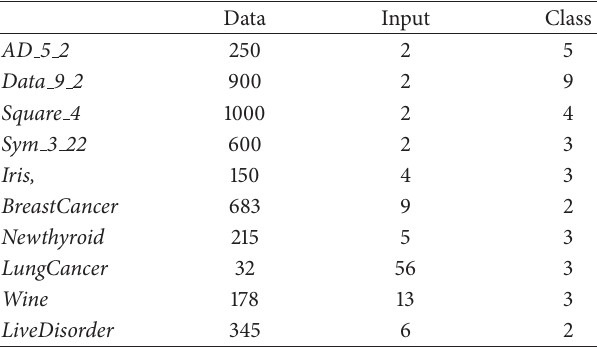
Table 1: Properties of the test data